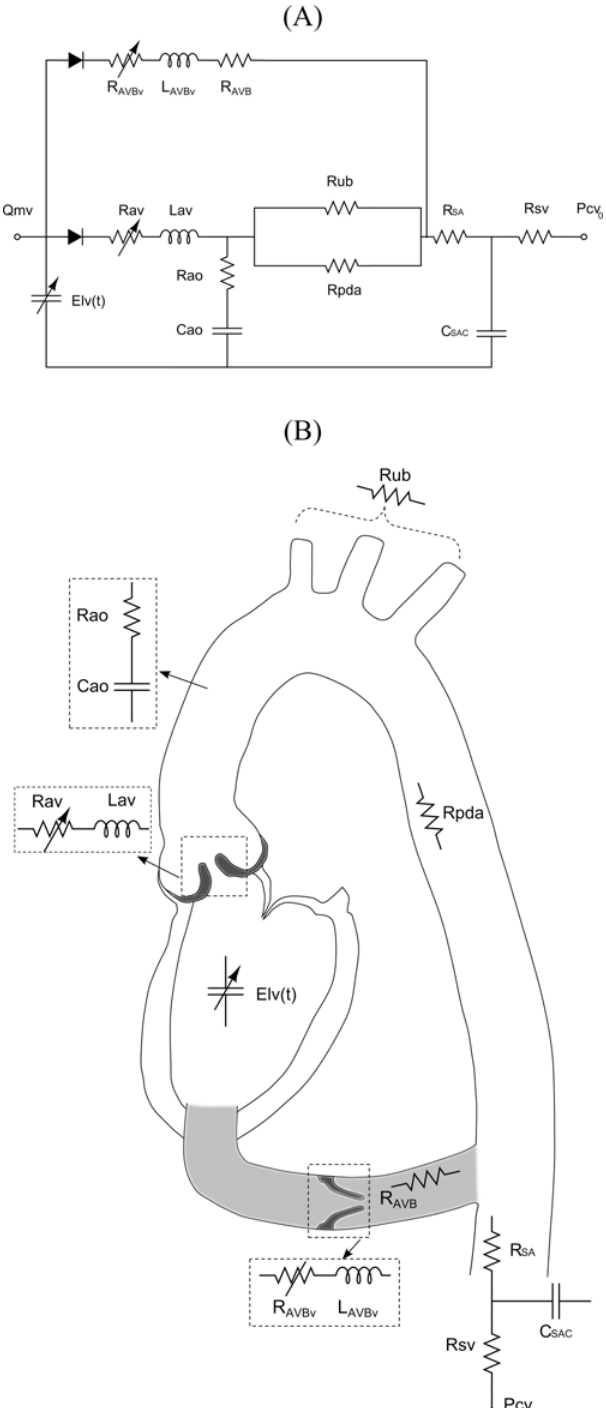
Fig 1. Schematic diagrams. (A) Electrical representation, (B) schematic representation of the lumped parameter model used to simulate left-sided heart in presence of aortic stenosis and/or apico-aortic conduit (please see Table 1 for all other parameters used in the lumped parameter